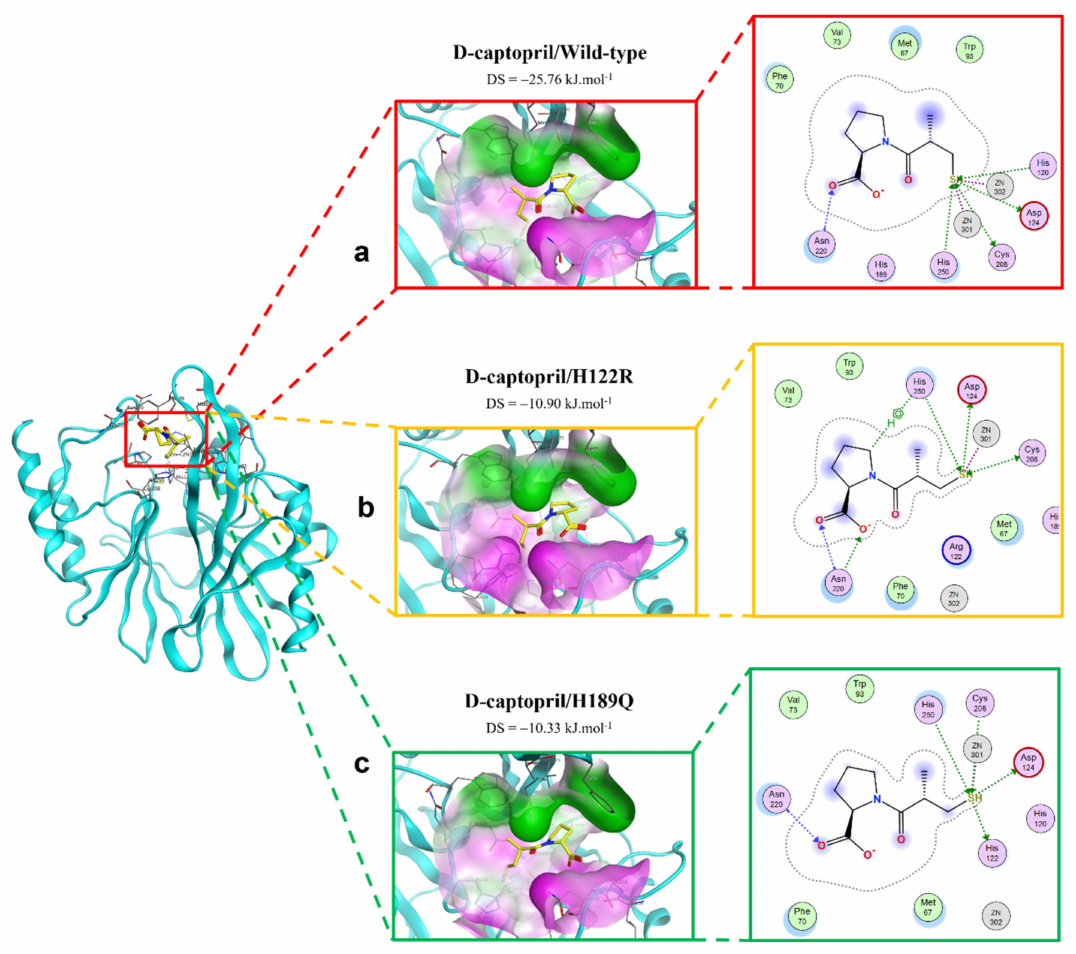
Figure 3. The binding site of d-captopril with NDM-1 wild-type and mutant proteins. ( a ) Wild type. ( b ) H122R. ( c )